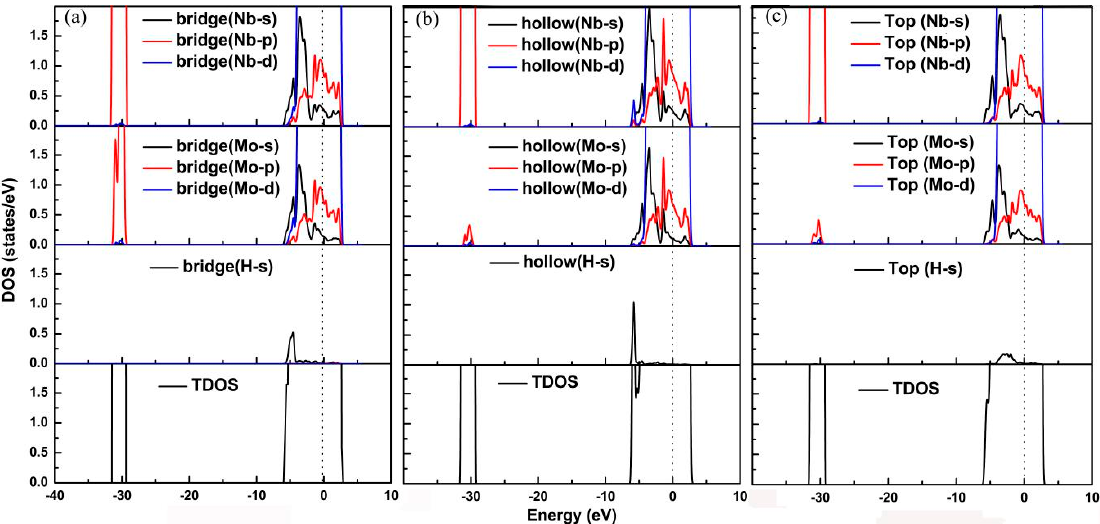
Figure 5. Calculated total and partial density of states of hydrogen atoms adsorbed onto Mo-doped Nb (100) surface at ( a ) B1 site, ( b ) H1 site, and ( c ) T1 site. The Fermi level is set to zero.